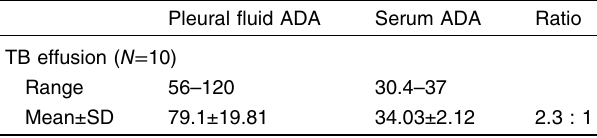
Table 7 ADA activity in pleural fluid and the serum in group